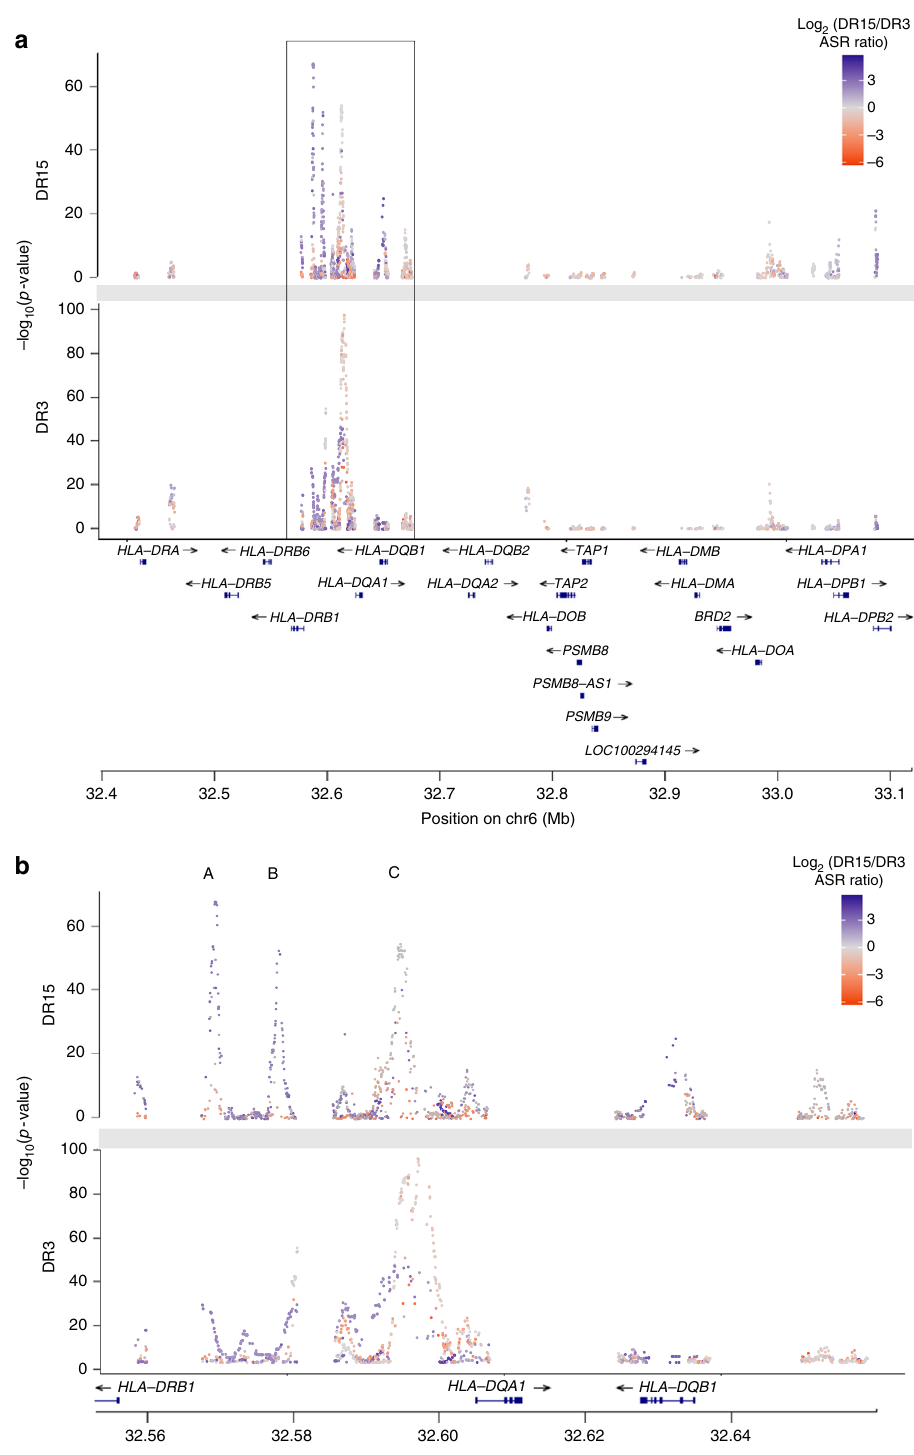
Fig. 3 HLA Class II hQTLs have disproportionate DR15/DR3 ASE ratios. a Representation of HLA Class II (32.4 – 33.1 Mb) hQTLs by individuals heterozygous for the HLA-DR15 (top panel) or HLA-DR3 (bottom panel) haplotypes. Y -axis is the − log 10 ( p ) from the CHT; chromosome position (Mb) is plotted on the x -axis. hQTLs are colored by the log 2 (DR15 allele speci fi c reads/DR3 allele speci fi c reads); dark purple values (max = 5.63) indicate more allele speci fi c reads at a particular SNP in the HLA-DR15 and dark orange values (min = − 6.11) indicate more allele speci fi c reads in the HLA-DR3 samples at a particular SNP. b Zoomed in region highlighted by black box in a (32.56 – 32.66 Mb) is displayed in b . Signals A (32.568 – 32.571 Mb), B (32.578 – 32.582 Mb), and C (32.588 – 32.606 Mb) are